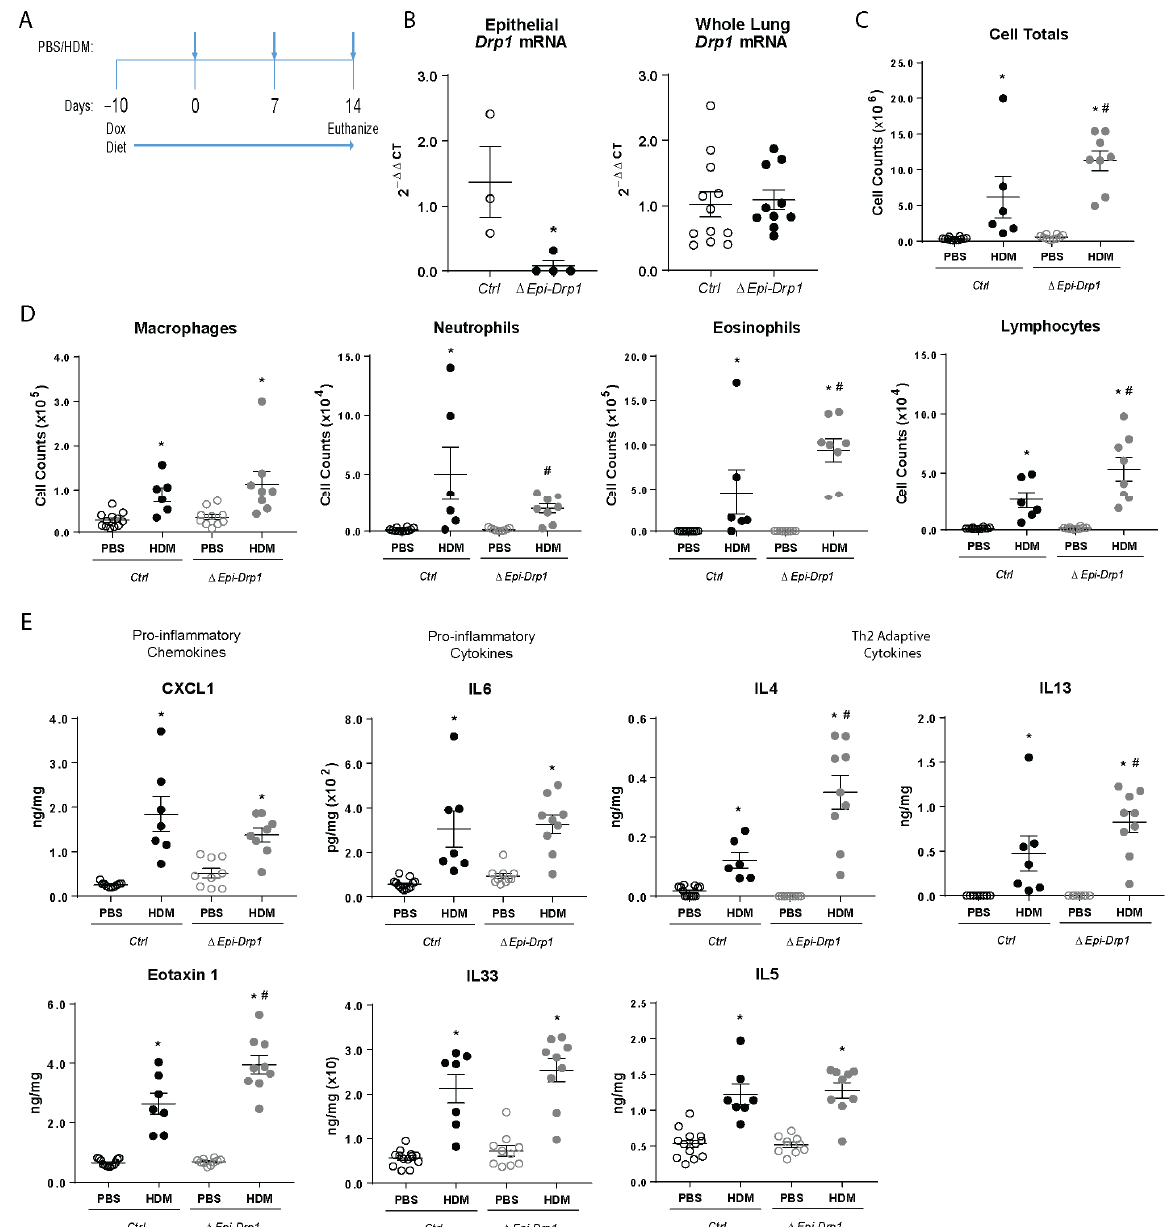
Figure 3. Epithelial specific Drp1 deletion enhances inflammatory cell migration to mouse lungs in response to HDM. ( A ) Deletion and HDM exposure protocol; ( B ) RT-qPCR assessment of Drp1 in lung epithelial lysates, n = 3 mice per group, and whole lung lysates, n = 10–12 mice per group from 2 experiments; ( C ) Total inflammatory cells present in the BALF, n = 6–12 mice per group from 2 experiments; ( D ) Inflammatory cell-specific totals in the BALF, n = 6–12 mice per group from 2 experiments; ( E ) ELISAs of inflammatory cytokines and chemokines in whole lung lysates, n = 6–13 mice per group from 2 experiments; ( B – E ) * p < 0.05 vs. corresponding PBS group, # p < 0.05 vs. Ctrl HDM group. Error bars represent mean ± SEM.